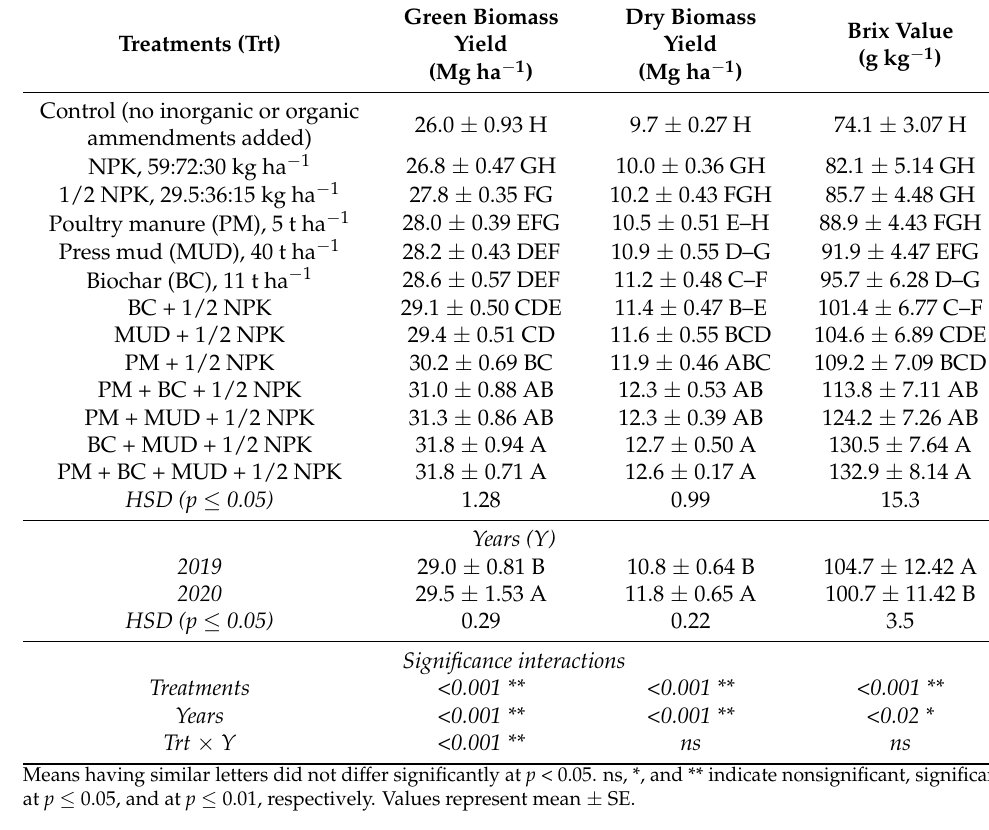
Table 3. Performance for green/dry biomass yield and brix value on fresh stalk of forage sorghum un- der different organic amendments under field conditions of Layyah, Pakistan, during 2019 and 2020.